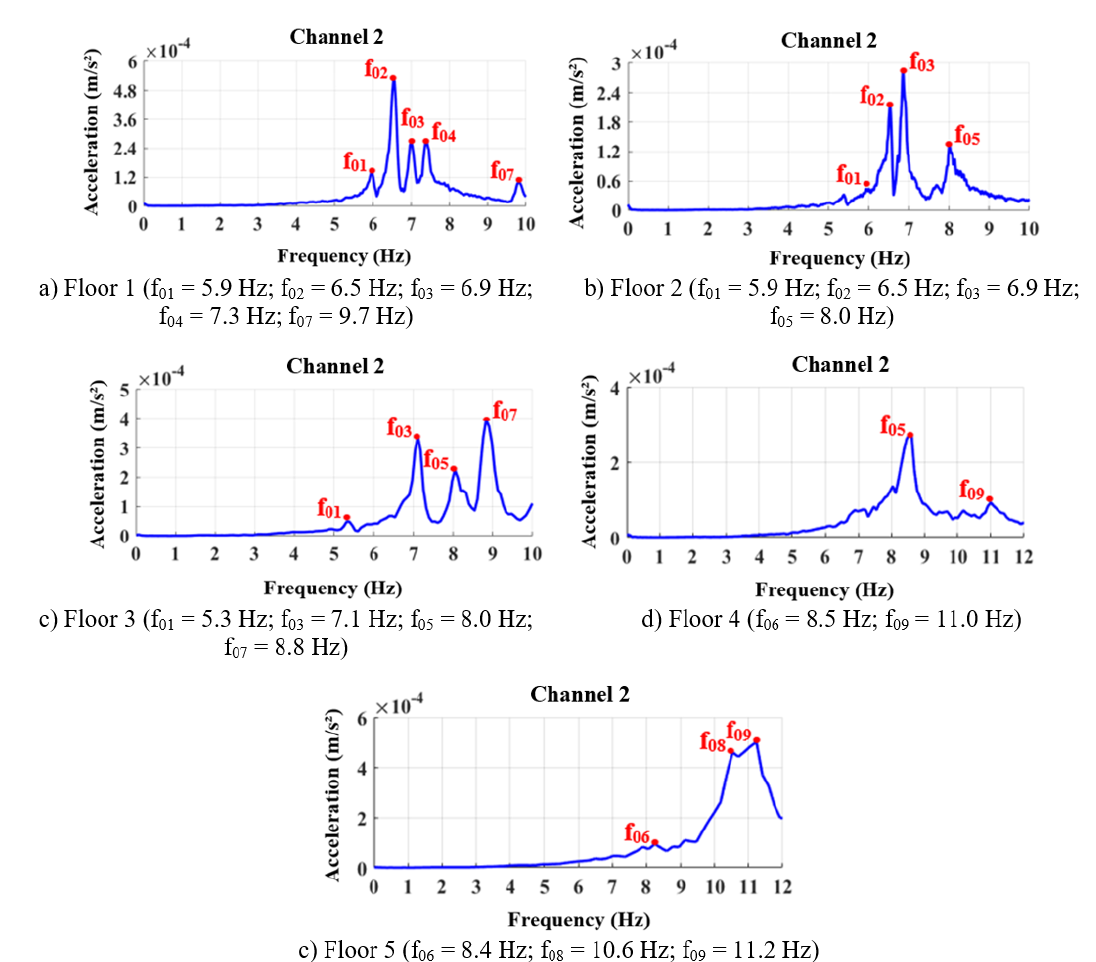
Figure 8. Floor’s vibration modes experimental FFT